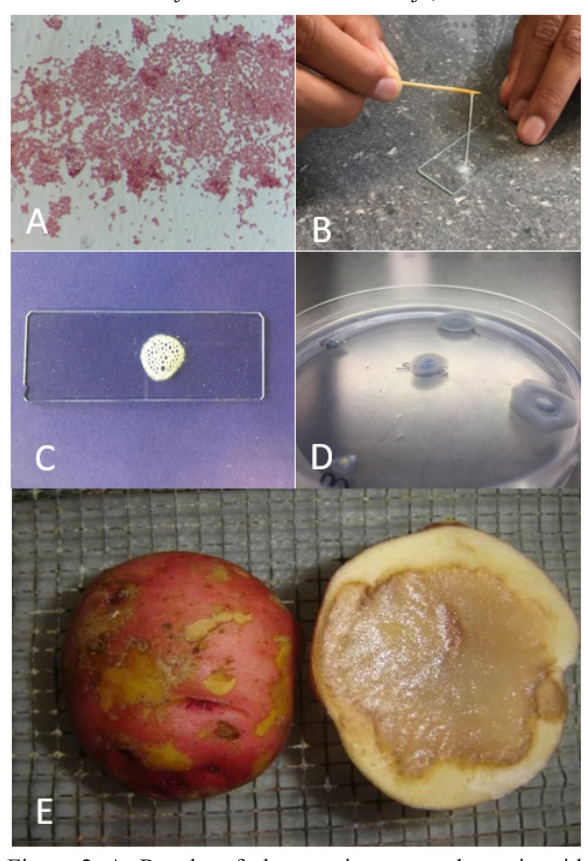
Figure 2. A. Results of phenotypic tests on bacteria with reddish colour. gram negative. B. positive to 3% potassium hydroxide. C. positive catalase. D. degradation of pectin in CPV medium. E. Sliced Potato Rot